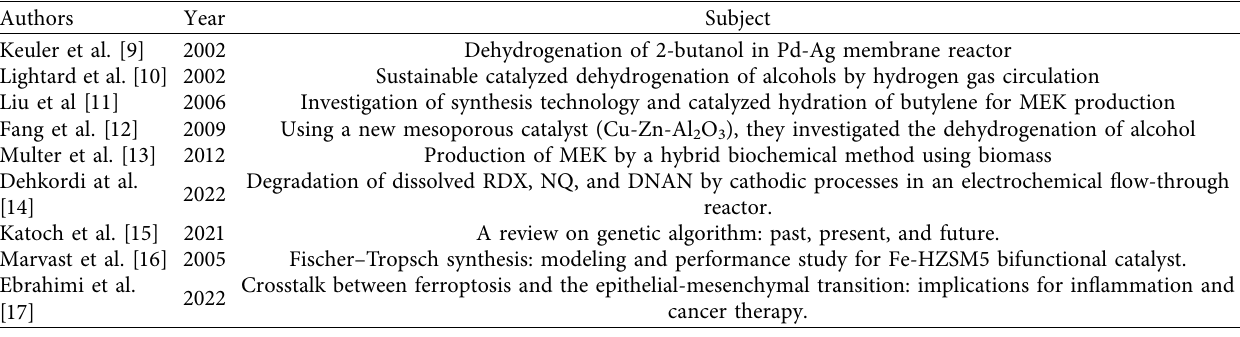
Table 1: Comparison of review